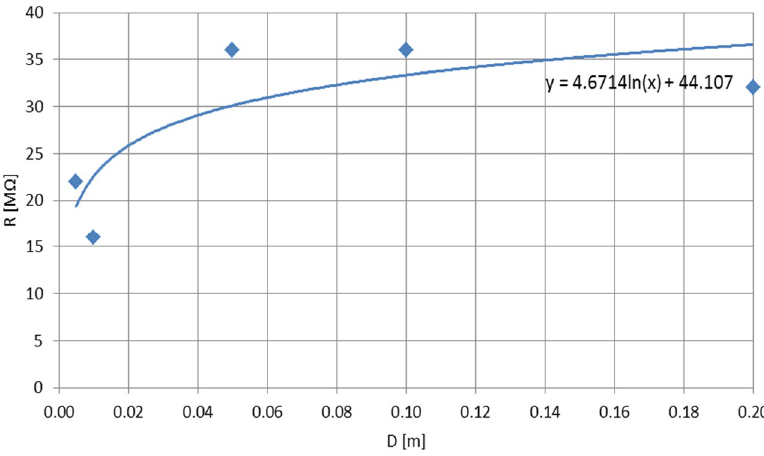
Figure 8. The resistance of the Glacier Paradise ice measured with increasing distance between the probes.